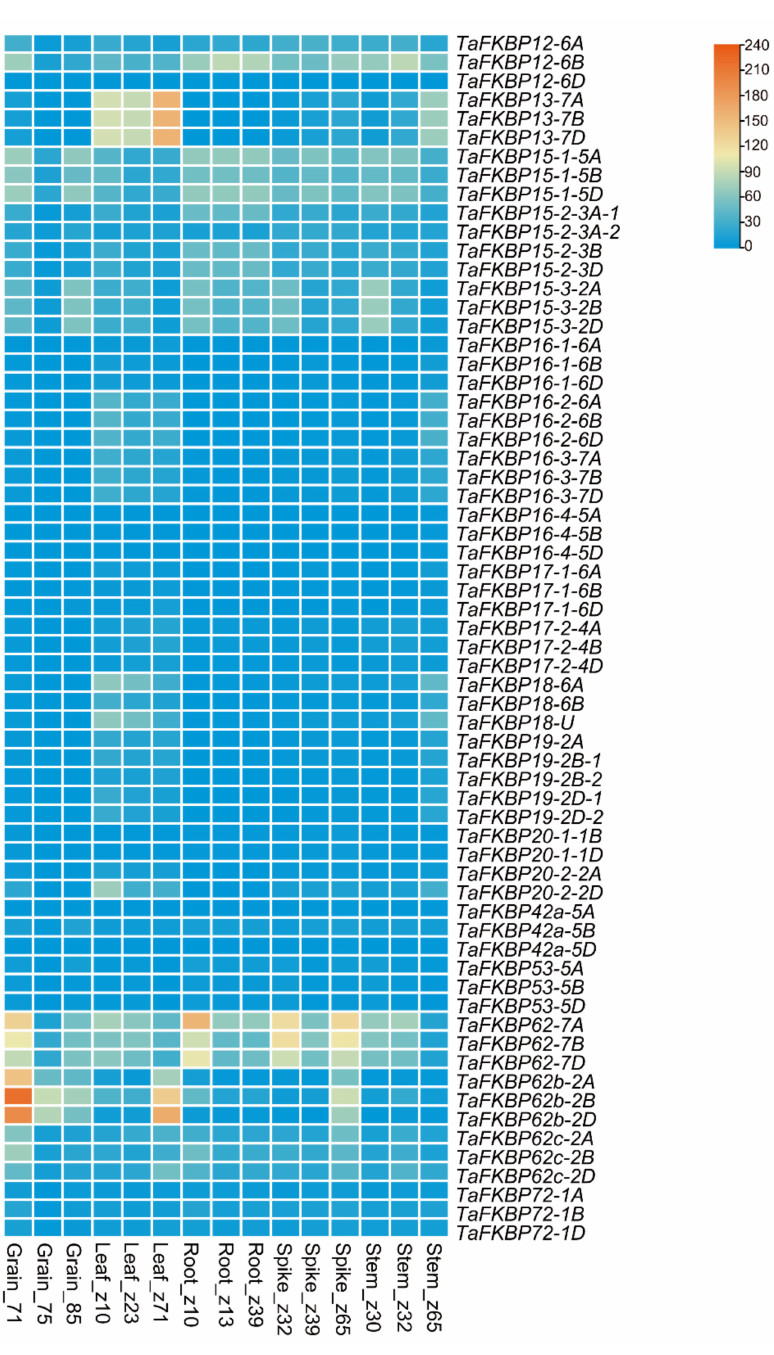
Figure 7. Heatmap representing the expression patterns of TaFKBP genes in various developmental stages. TPM values were directly used to create the